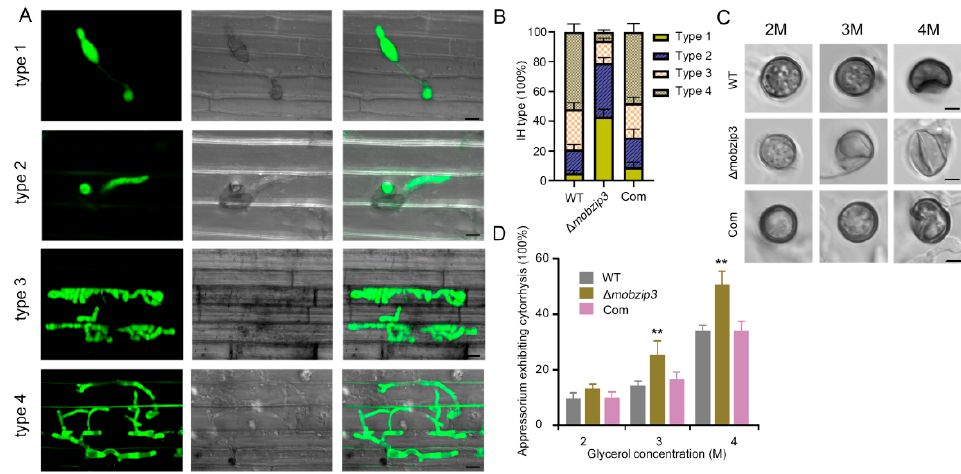
Figure 3. Defects of the ∆ mobzip3 mutant in plant infection. ( A ), GFP labeled M. oryzae were used to infect rice sheath cells. Images showing the four types of invasive hyphae (IH) in rice cells (type 1, no hyphal penetration; type 2, IH with fewer than two branches; type 3, IH with more than two branches; and type 4, IH that fully occupies a plant cell and moves into neighboring cells) Bar = 20 µ m. ( B ), Growth of the IH in rice cells was quantified and statistically analyzed at 36-h post-inoculation for WT, ∆ mobzip3 and the complemented strain. Error bars represent SD, n ≥ 50 cells. ( C ), Appressorium turgor analysis using an incipient cytorrhysis (cell collapse) assay. Representive images showing the conidia of WT, ∆ mobzip3 and the complemented strain were put in glycerol (2–4 M) for 10 min. Bar = 5 µ m. ( D ), Quantification of the collapsed cells in ( C ). The percentage of collapsed appressorium was recorded by observing at least 100 appressorium and the experiment was repeated three times. Error bars represent standard deviation and asterisks (**) represent a significant difference ( p < 0.01).